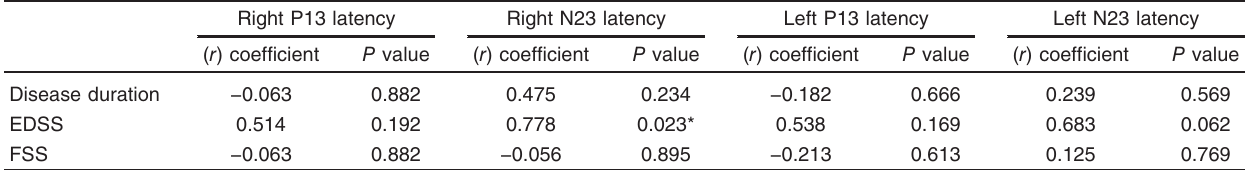
Table 6 Correlation between vestibular-evoked myogenic potential latency and clinical characteristics of patients with multiple sclerosis Right P13